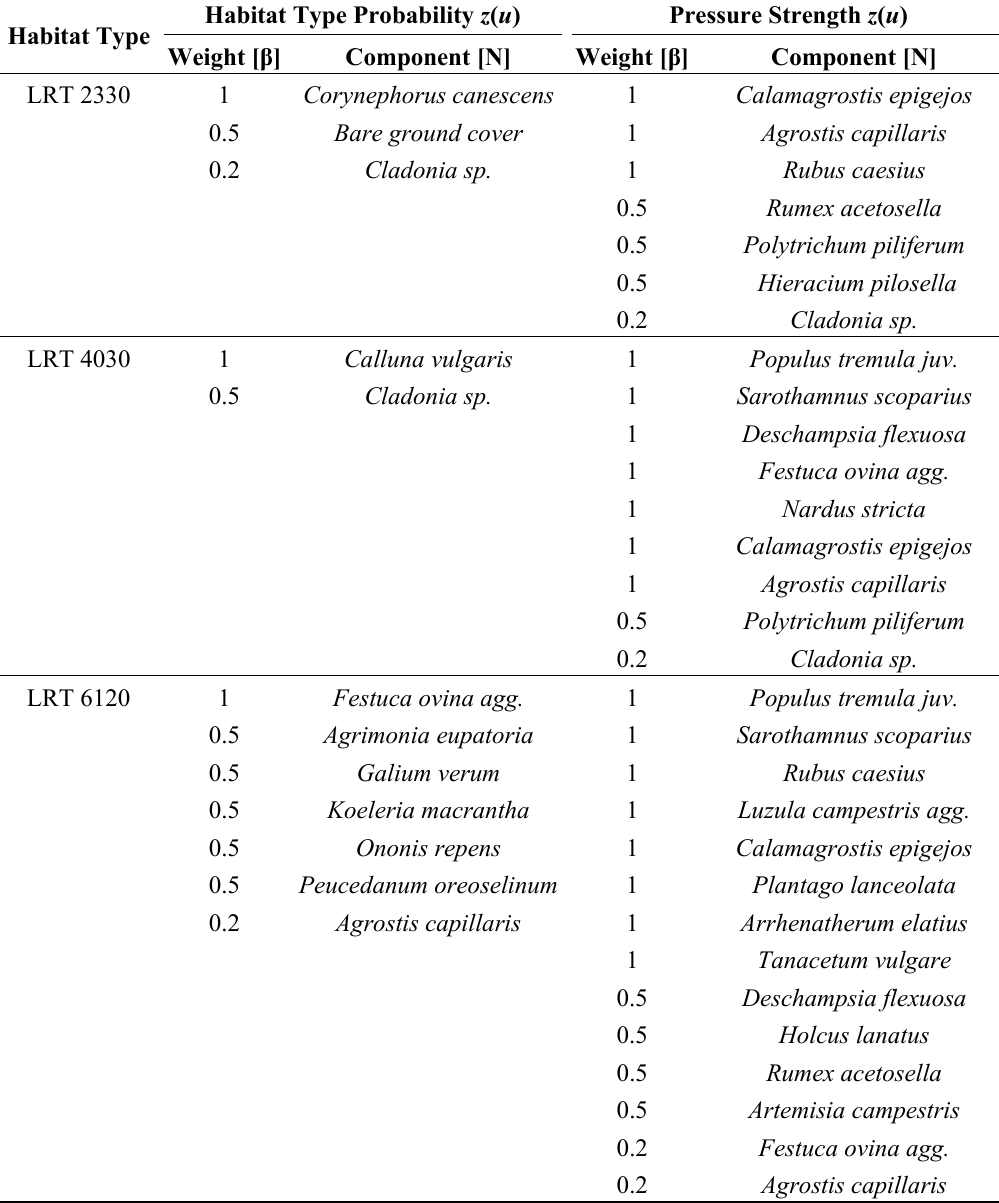
Table 1. Species list for habitat-type-specific habitat functions. Species are aggregated according to weighted composites of habitat indicator species (indicating a Natura 2000 habitat type) and pressure indicator species (indicating habitat conversion/threat) in order to represent typical habitat realizations within the ordination space of the study